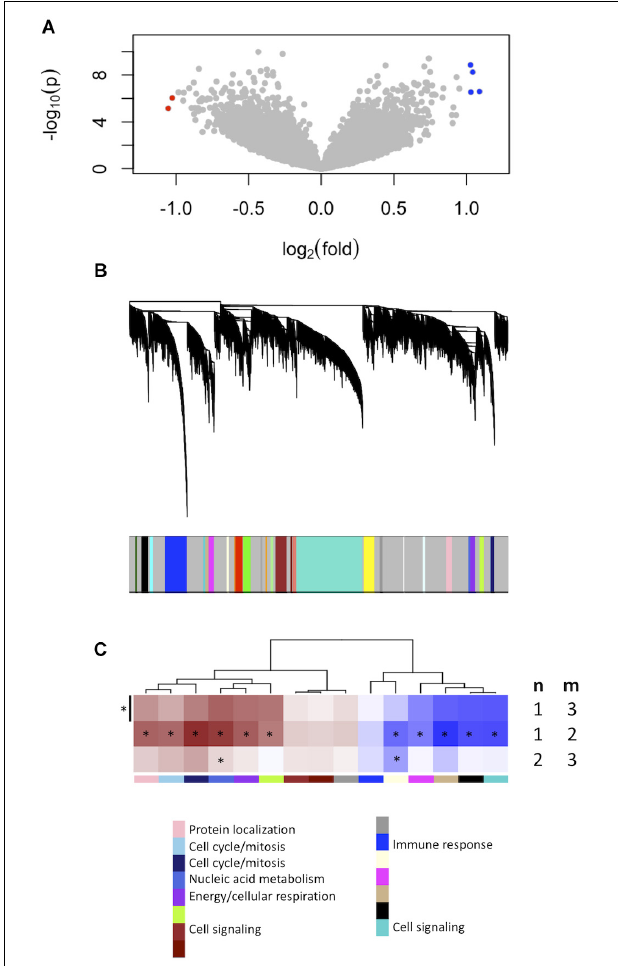
FIGURE 1 | Gene expression signatures associated with meningioma grade. (A) Differential gene expression between grades 3 and 1 meningiomas reveal four upregulated and two downregulated genes in grade 3 tumors [| log 2 (fold change)| ≥ 1.5, p < 0.0001] highlighted with blue and red dots, respectively. (B) Gene co-expression networks analysis. Dendrogram of genes based on the topological overlap map, with the 29 gene modules represented by colors in the bar below. Gray represents unclassified genes. (C) Plot of median module meta-gene expression differences between grades (“m” versus “n”). Only modules with significantly different expression between grades 1 and 3 are included (Mann–Whitney p < 0.05). Red indicates modules which are upregulated in grade (m), and darker shades indicate larger effect sizes. Notably, 11/15 modules are significantly different between grades 1 and 2 while 2/15 are also significantly different between grades 2 and 3. * p < 0.05